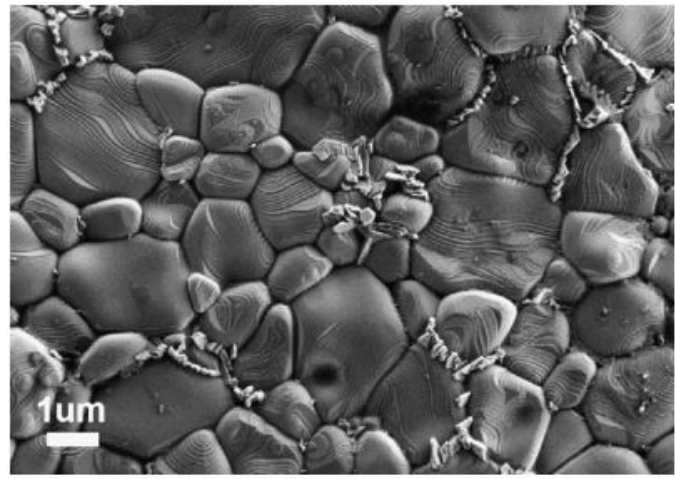
Figure 12. FESEM surface images of MW-sintered CCTO for 120 min that was pre-sintered at 1000 °C/10 h using a conventional furnace [73].